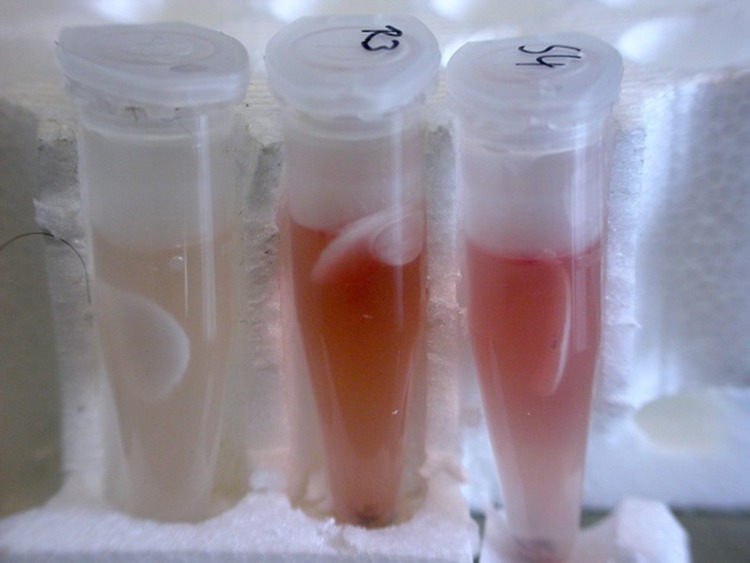
Results of the Griess assay with beewolf eggs.The left reaction vial is a control without beewolf egg, the other two vials containd eggs that were placed in the lid within 1 hr of oviposition. Vials were incubated at 25°C for 24 hr.